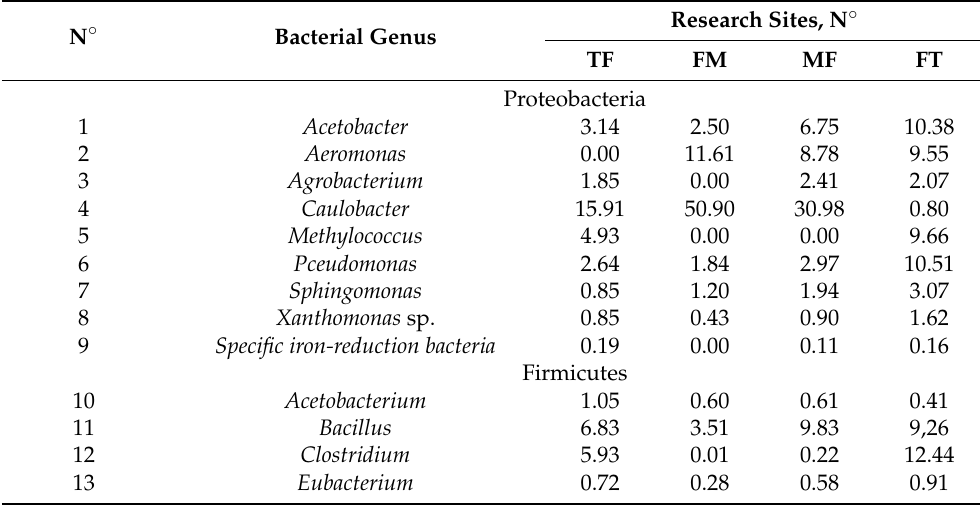
Table 3. Taxonomic structure of reconstructed microbial communities in soils along an elevation gradient in Mount Kivakka of North Karelia